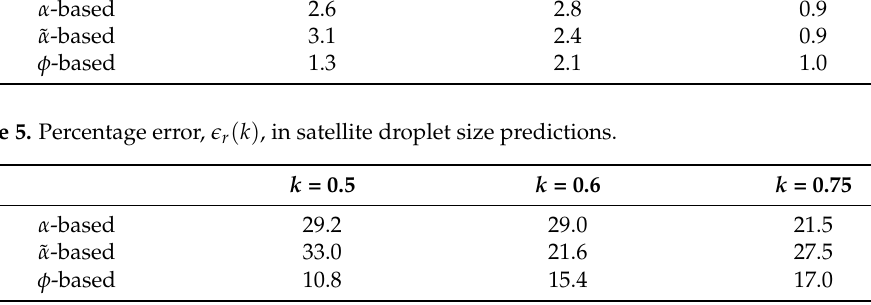
Figure 10. Comparison between main and satellite droplet radii between simulations and theoretical predictions from [32]. Theoretical predictions are in dashed lines, and the top and bottom curves are, respectively, the main and satellite droplet calculations. Table 4. Percentage error, (cid:101) r ( k ) , in main droplet size predictions. k = 0.5 k = 0.6